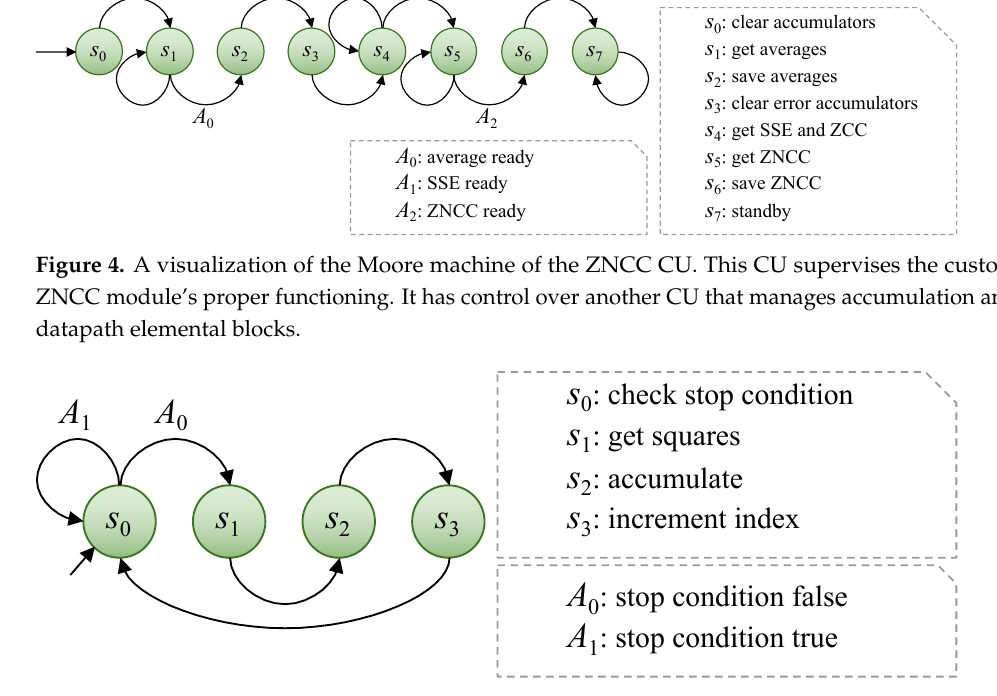
Figure 5. A Moore machine illustration describing the behavior of the accumulation CU. Summations constitute the vast majority of the sequential operations required to compute ZNCC, which is why the flow of those operations should be managed by means of a separate control